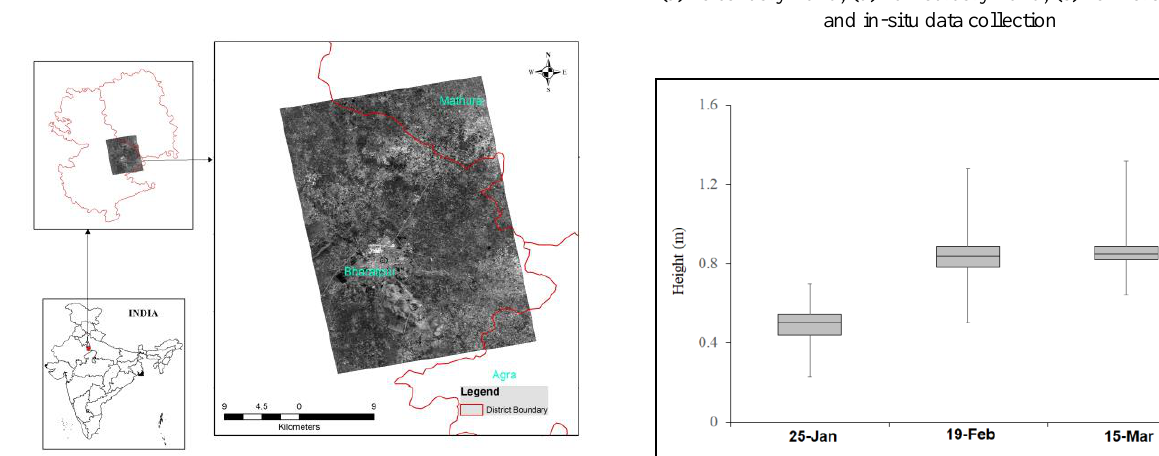
Figure 3. Box chart of in-situ wheat plant